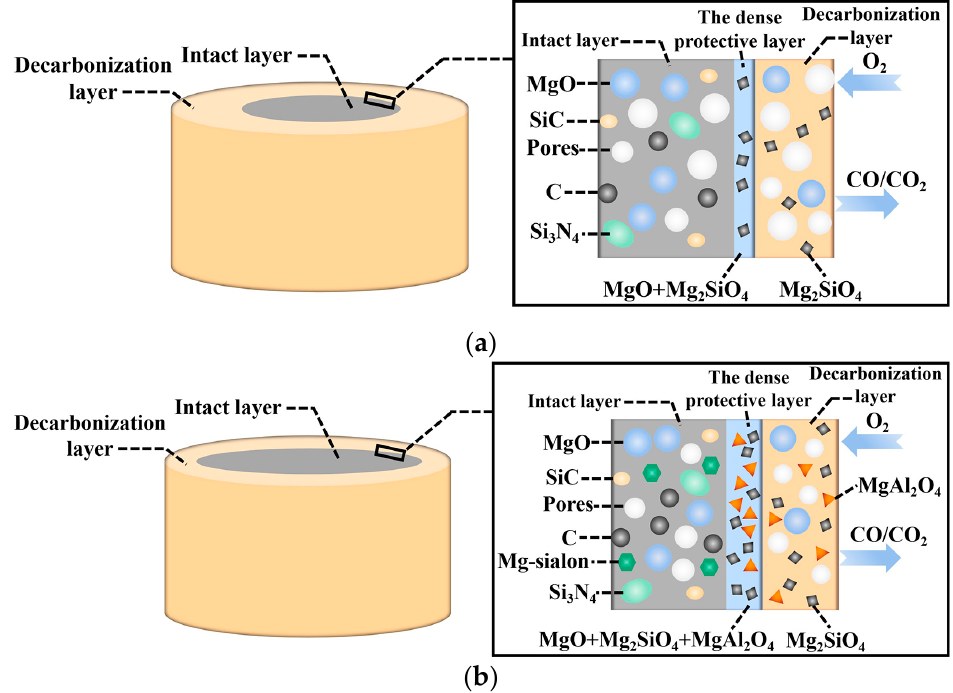
Figure 11. Schematic diagram of the oxidation of the low-carbon MgO-C refractories: ( a ) without Mg-sialon, ( b ) with Mg-sialon.